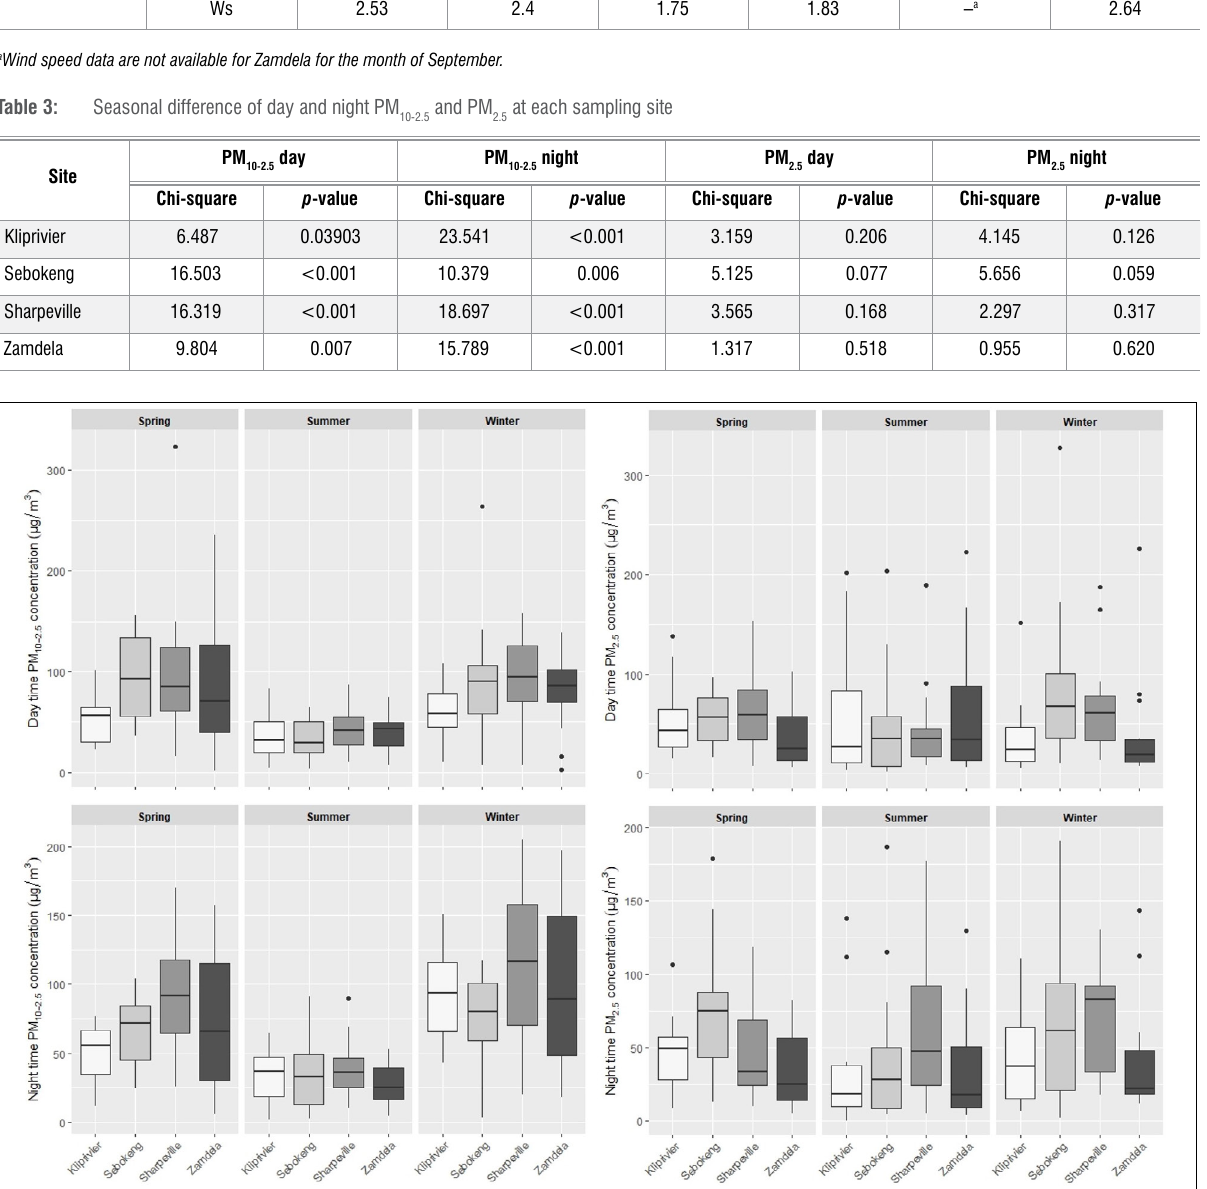
and PM mass concentration at all the sampling sites (16 observations per site). 10-2.5 2.5